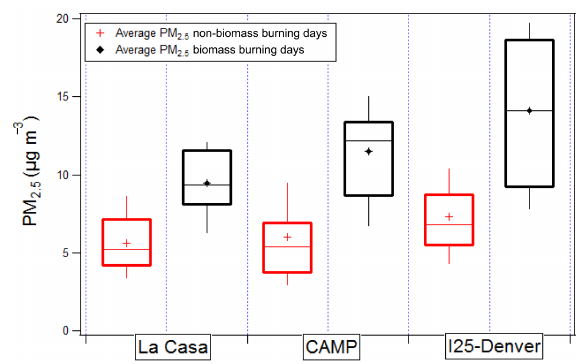
Figure 6. Daily (09:00–19:00 local time) average PM 2 . 5 mass con- centration for 3 monitoring sites for (a) non-biomass-burning days of 26, 29, and 31 July and 2, 3, 7, 8, 15, 16, and 18 August and (b) biomass burning days of 11 and 12 August. The whisker top, whisker bottom, box top and box bottom represent the 90th, 10th, 75th, and 25th percentiles, respectively.